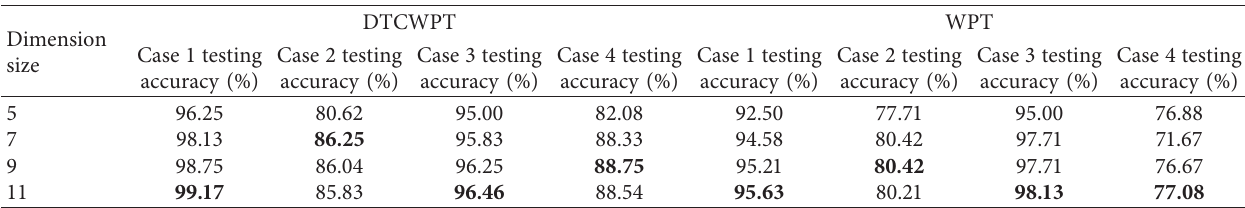
Table 7: Bearing fault diagnosis results obtained by OFS-LDA-SVM.